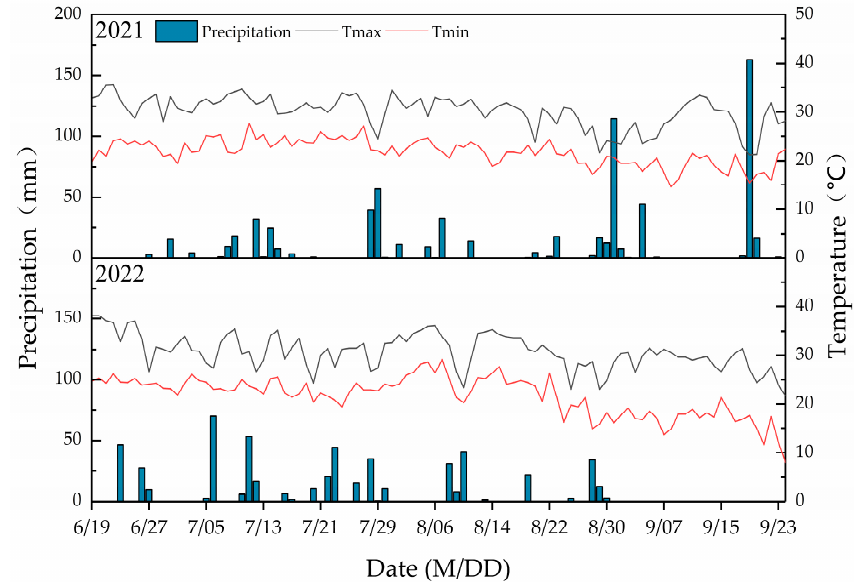
Figure 1. Daily maximum temperature (Tmax), daily minimum temperature (Tmin), and daily precipitation at the experimental station during the 2021 and 2022 summer maize growing seasons. Summer maize was planted in experimental plots with an area of 3 m × 3 m, sur- rounded by bricks and concrete (1.50 m deep) to prevent the horizontal flow of